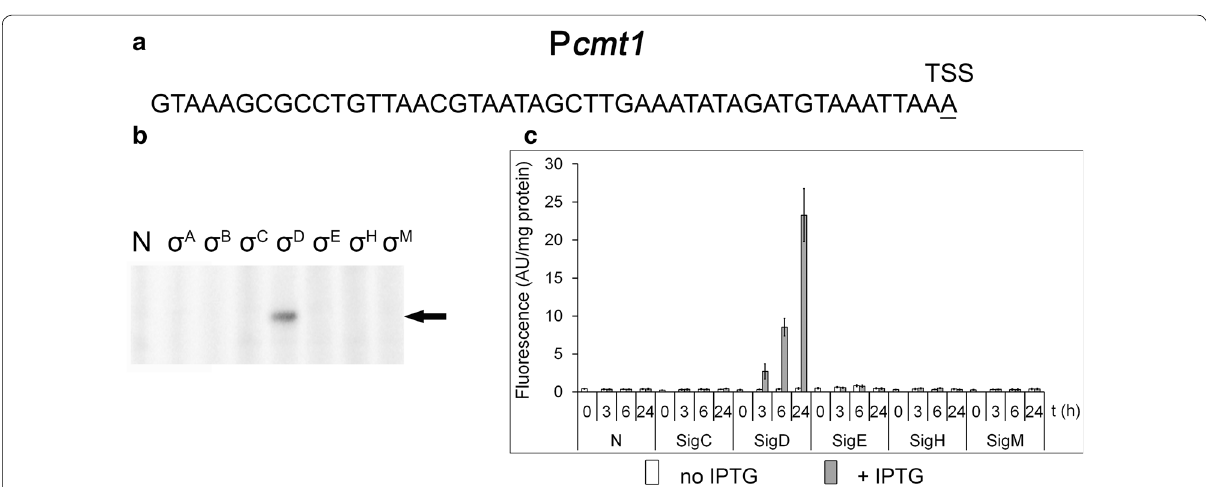
Fig. 4 Assignment of a sigma factor to the P cg2556 promoter. a Sequence of the cg2556 ( cgR_2208 ) promoter (Toyoda and Inui 2016a). The and 10 sequence elements are in bold , the transcriptional start site is underlined . b In vitro transcription with P cg2556 as a template. Individual − sigma factors associated with RNAP are shown at the top . N no sigma was added to the RNAP core. The specific transcript is indicated with an arrow . c P cg2556 activity determined with the two-plasmid system in C. glutamicum WT by measuring the fluorescence intensity of the Gfpuv reporter. The sigma factors whose genes were overexpressed are indicated at the bottom . The SDs of three measurements are depicted as error bars